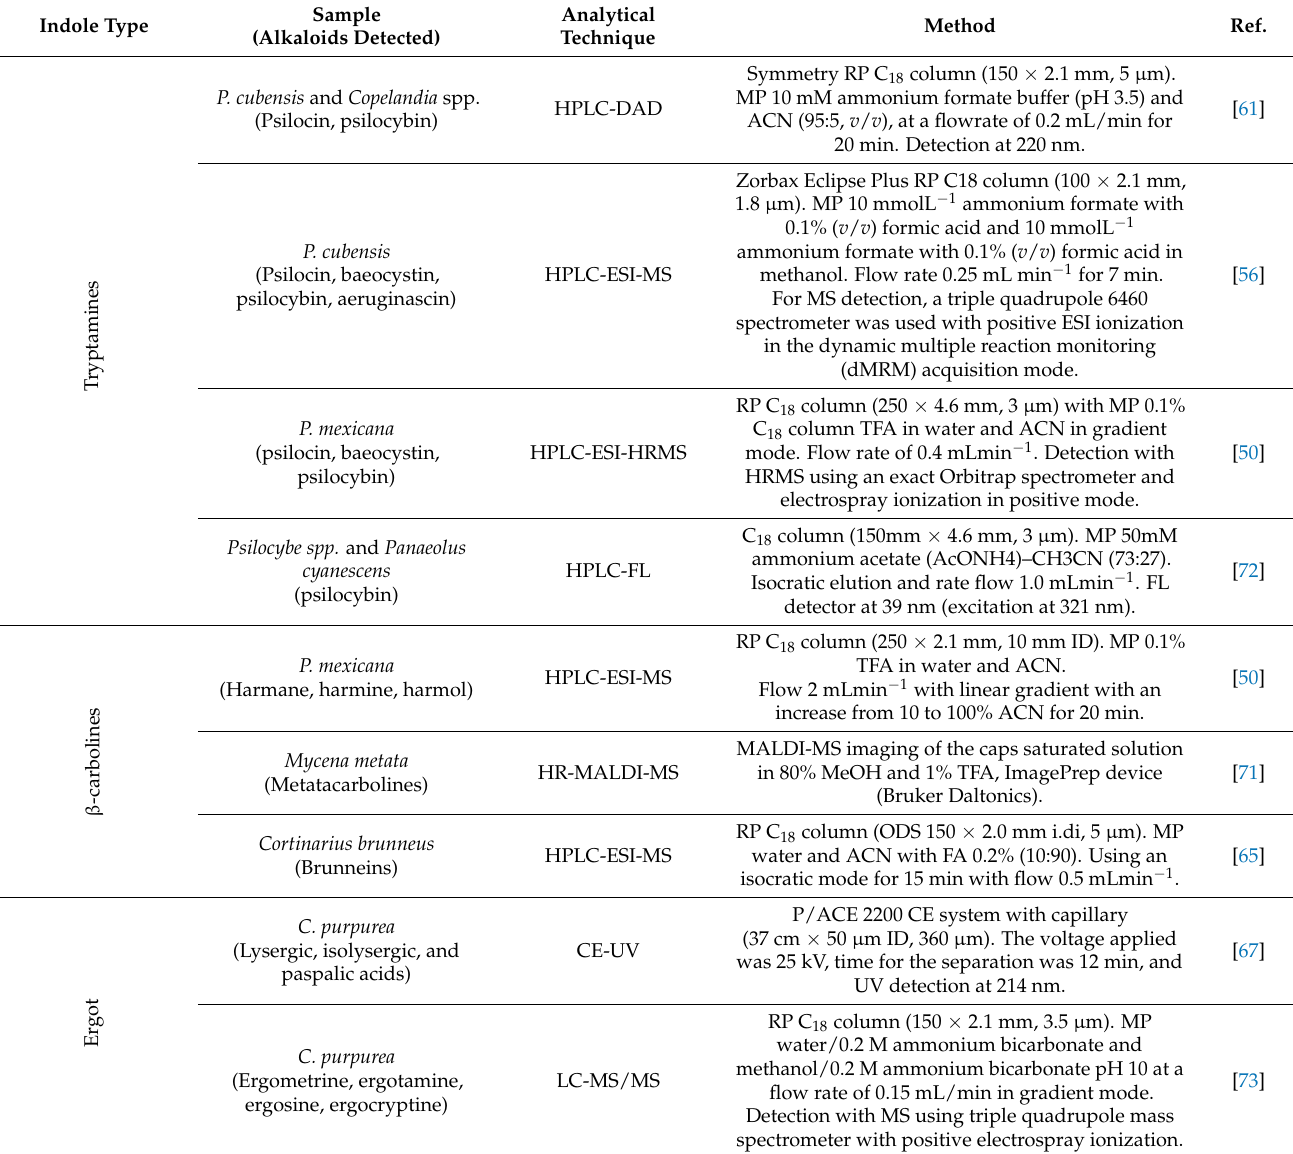
Table 4. Analytical methods for detection and quantification of psychedelic indole alkaloids in